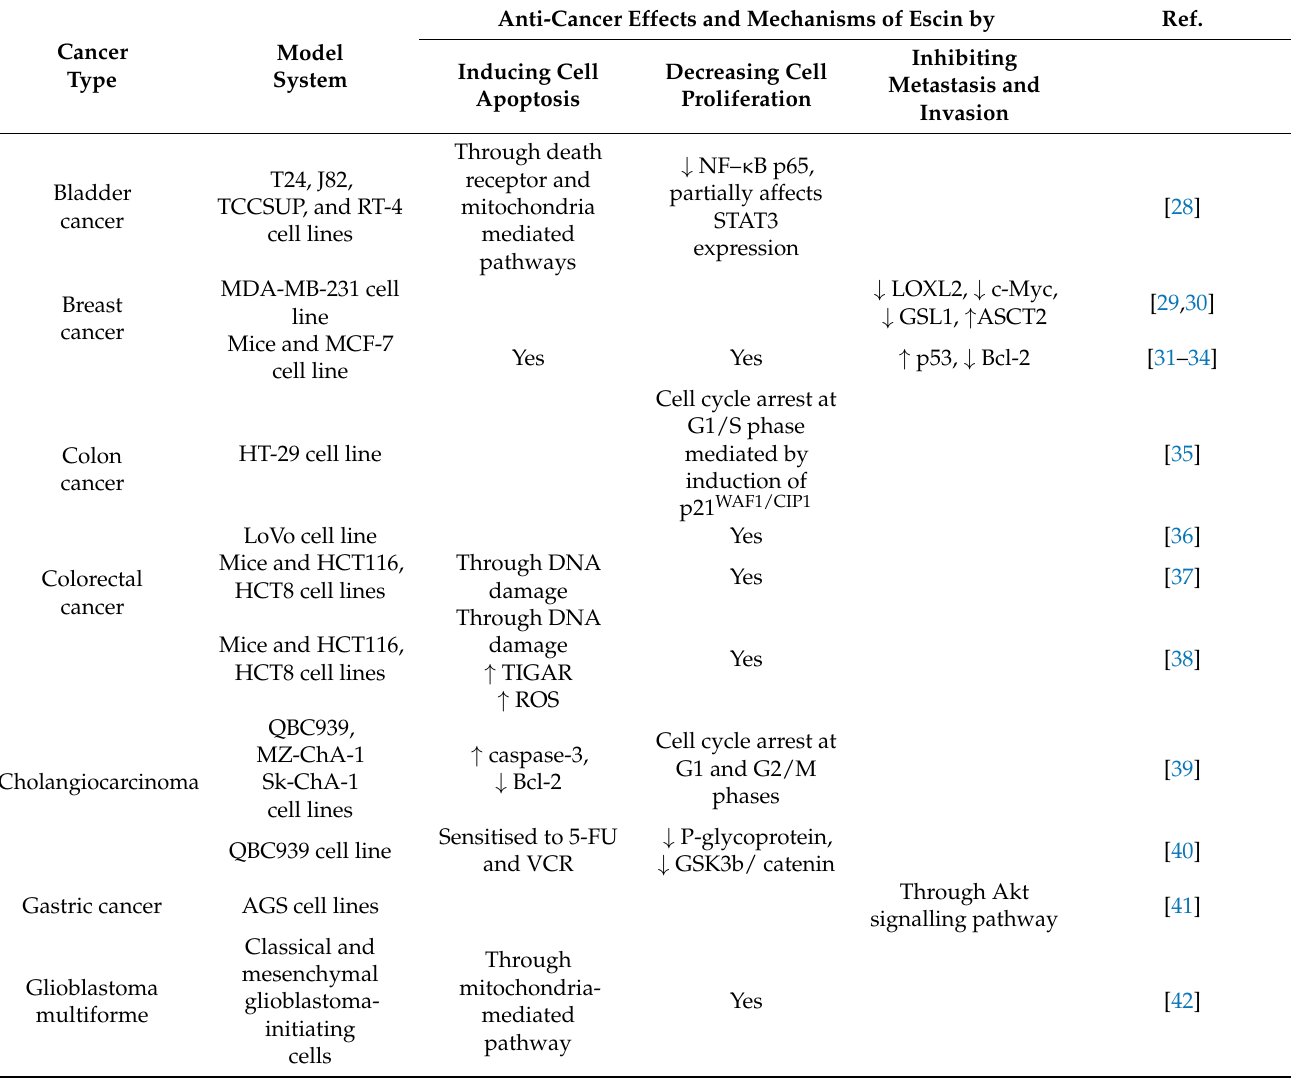
Table 2. Anti-cancer effects of escin revealed by in vitro or in vivo